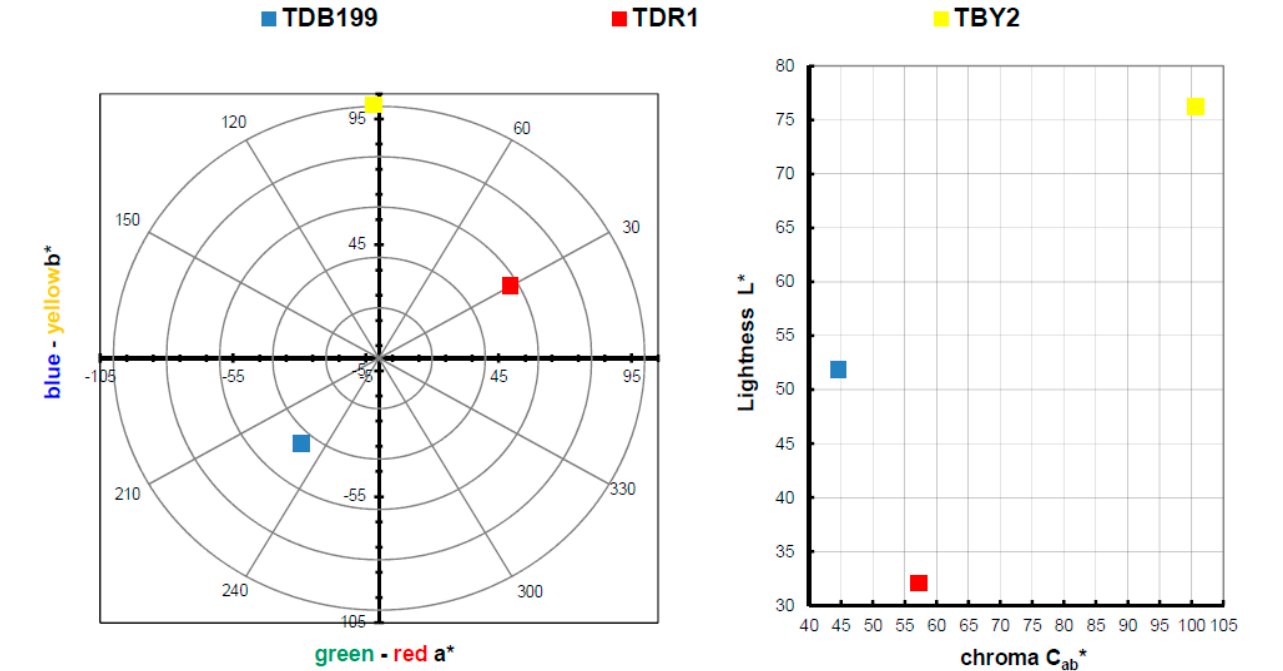
Figure 6. Graphic CIELAB plots for hybrid printed using the D65 illuminant and the CIE-1931 XYZ standard observer. ( Left ): CIE-a*b* color diagram; ( right ): CIE-Cab*L* color chart.